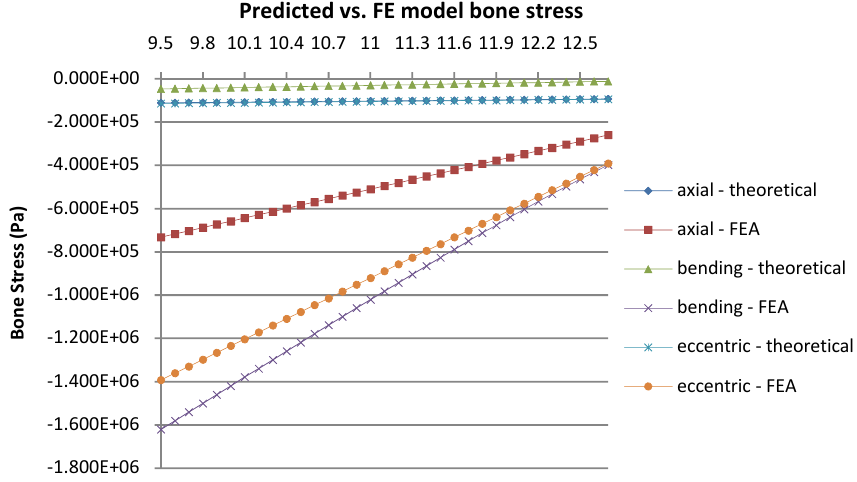
Fig.4 Axial loading of a simple direct contact bone-plate model